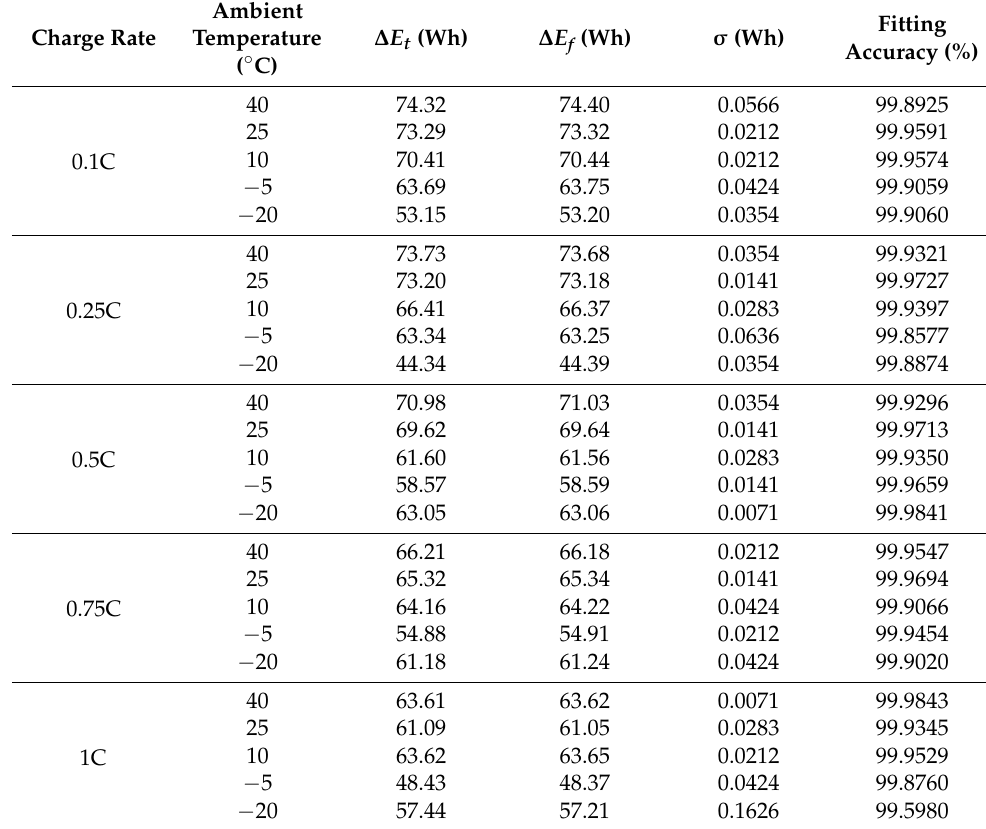
Table 3. Charge energy comparison during the